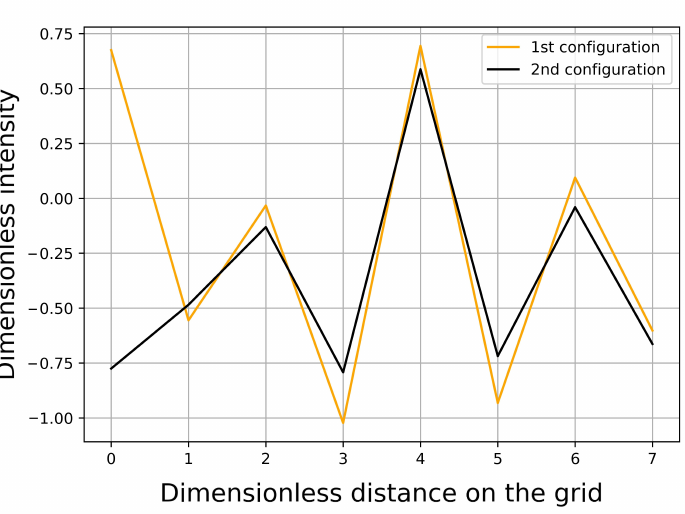
Figure 11. Similar characteristics of the scattered waves corresponding to the left-hand side